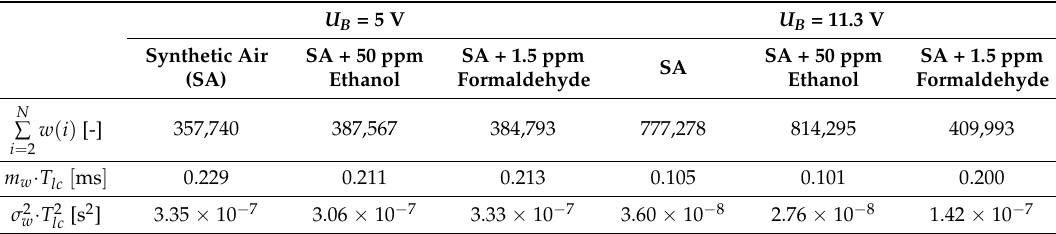
Table 2. Level-crossing parameters for voltage fluctuations at a time rate T lc equal to 10 − 5 s across an AuNP-based gas sensor for the shown gases and bias voltages ( U B ). U B = 5